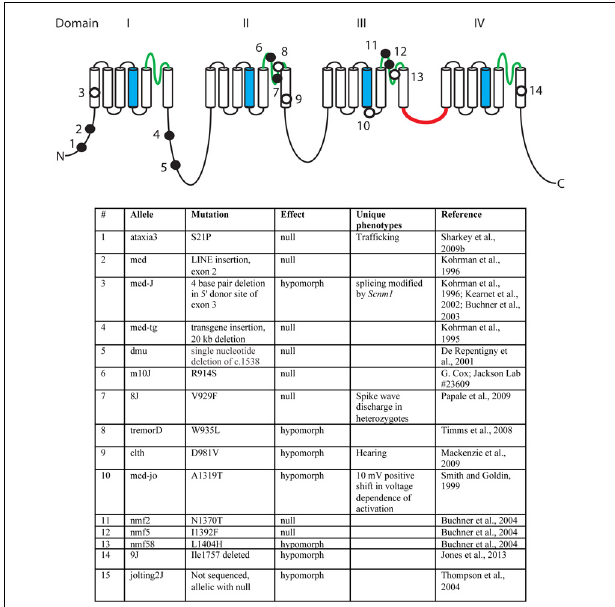
FIGURE 3 | Mutations of mouse Scn8a . Fourteen allelic mutations are shown on the channel backbone as described in Figure 2 . Amino acids are numbered according to Genbank AF049617. Filled circles, null alleles; open circles, hypomorphic alleles.